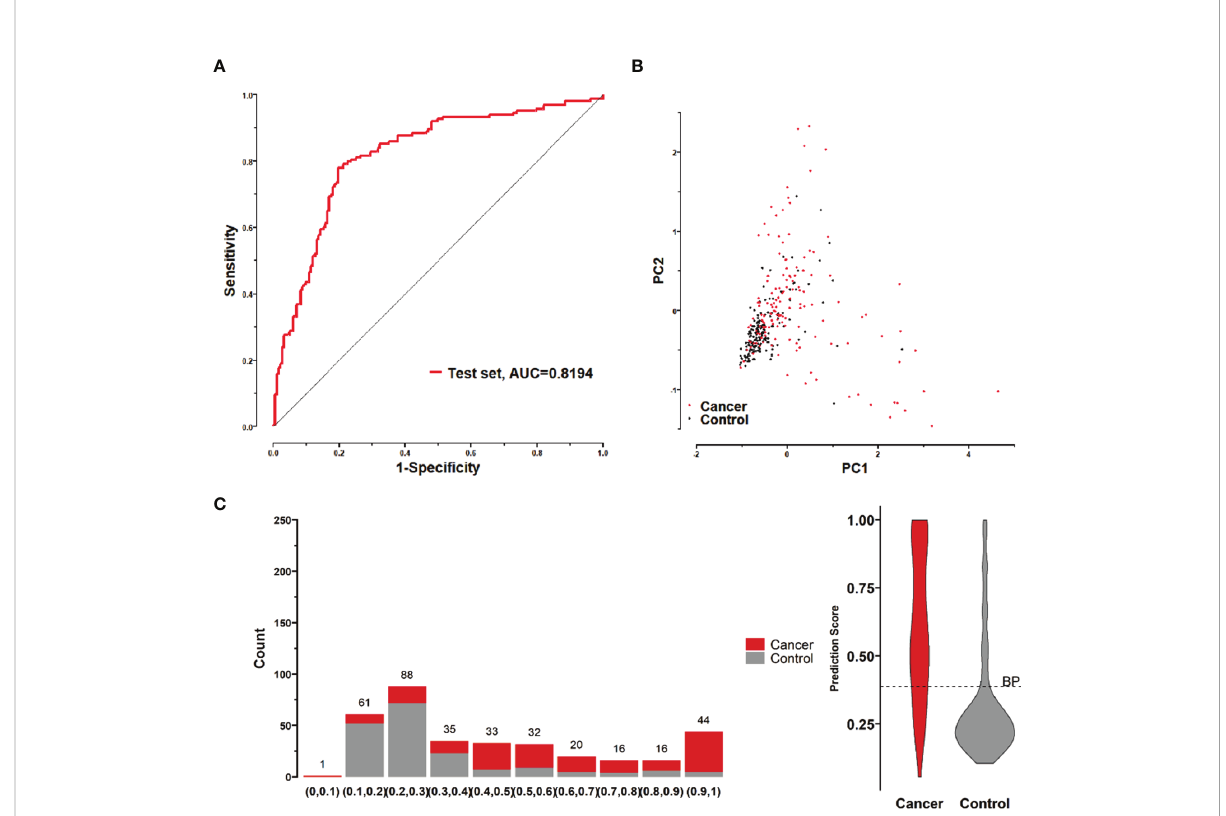
FIGURE 8 (A) ROC curve of the logistic model composed of 8 lung cancer antigens in the test set; (B) Principal component analysis of the test set samples in terms of the abundance of 8 lung cancer antigens, and scatter plots with the principal component 1 and principal component 2 as coordinates for samples in the control and tumor groups. (C) Distribution of the prediction scores in the test set for the logistic model composed of 8 lung cancer